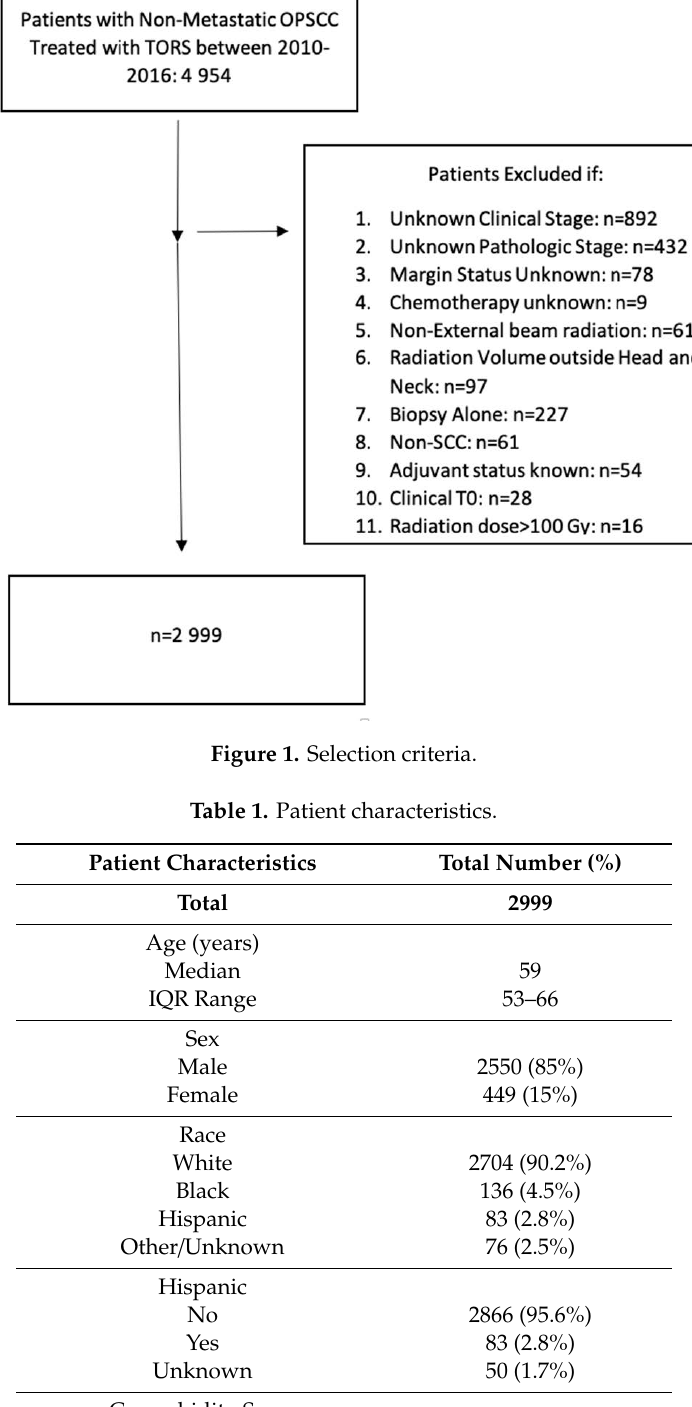
Table 1. Patient characteristics.